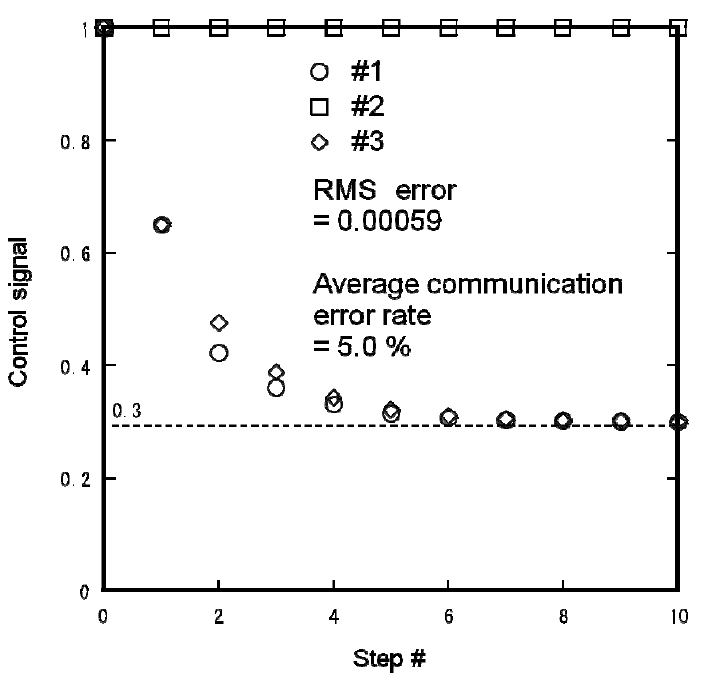
Figure 13. Experimental distributed lighting result obtained using Mote testbed for { s , s , s } = {0,1,0}. 1 2 3